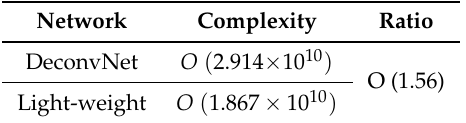
Table 2. Complexity comparison of the two